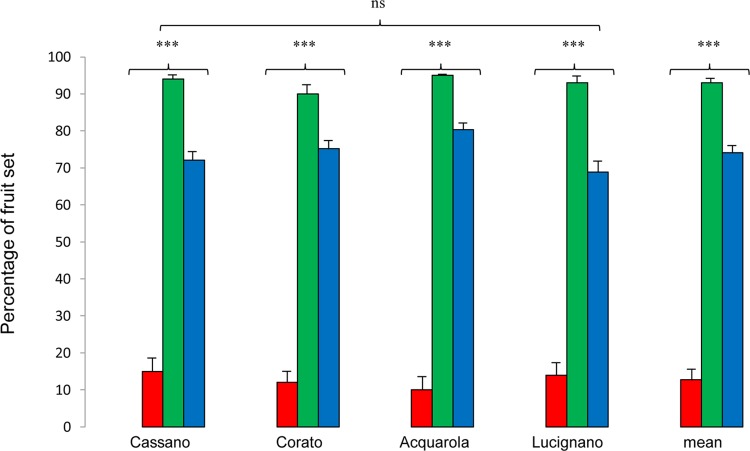
Fruit set in four populations of I. tuberosa and mean value for hand-pollination treatments: artificial selfing (red scale bars), outcrossing (green scale bars) and natural open-pollinated (blue scale bars). Spontaneous autogamy and agamospermy are not represented in the figure because the fruit set was 0 % in all populations (ns: not significant; ***P < 0.001).